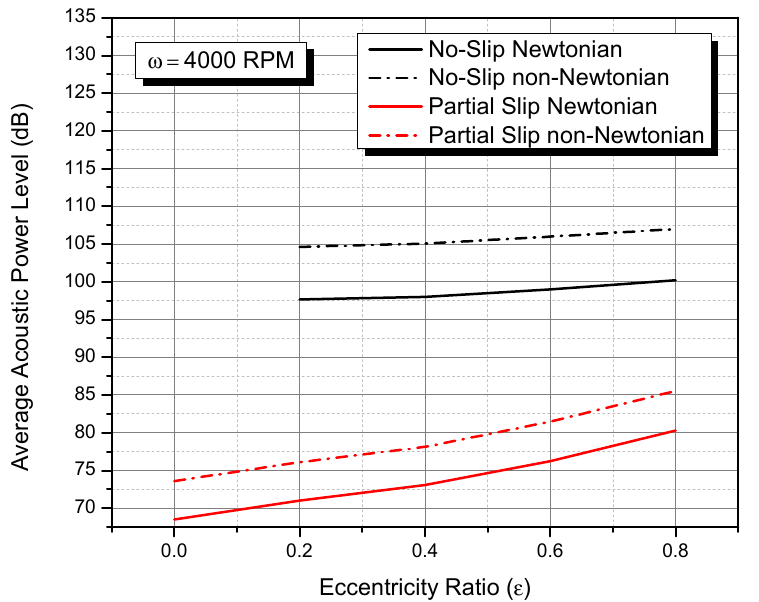
Figure 13. Average acoustic power level of journal bearing for several cases varying the eccentricity ratios.